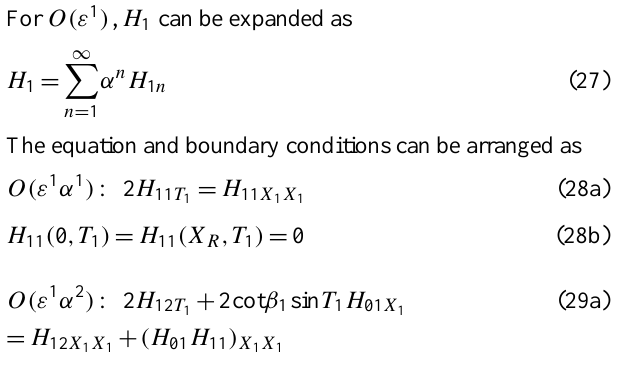
The coefficients a 1 , a 2 , δ 11 , δ 12 , δ 13 , δ 14 , b 1 , b 2 , c 1 , c 2 , c 3 and c 4 in Eqs. (22) and (26), defined in Table 1, are